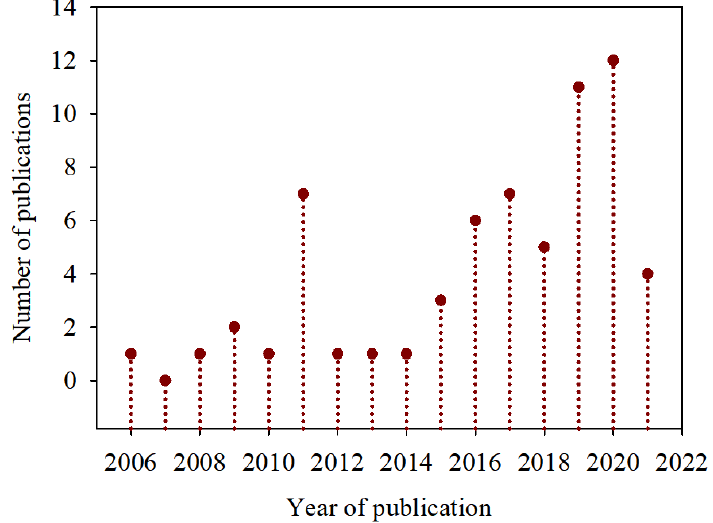
Figure 1. A number of scientific publications on probiotics in citrus fruits over the years (research carried out in the Scopus database in May 2021).